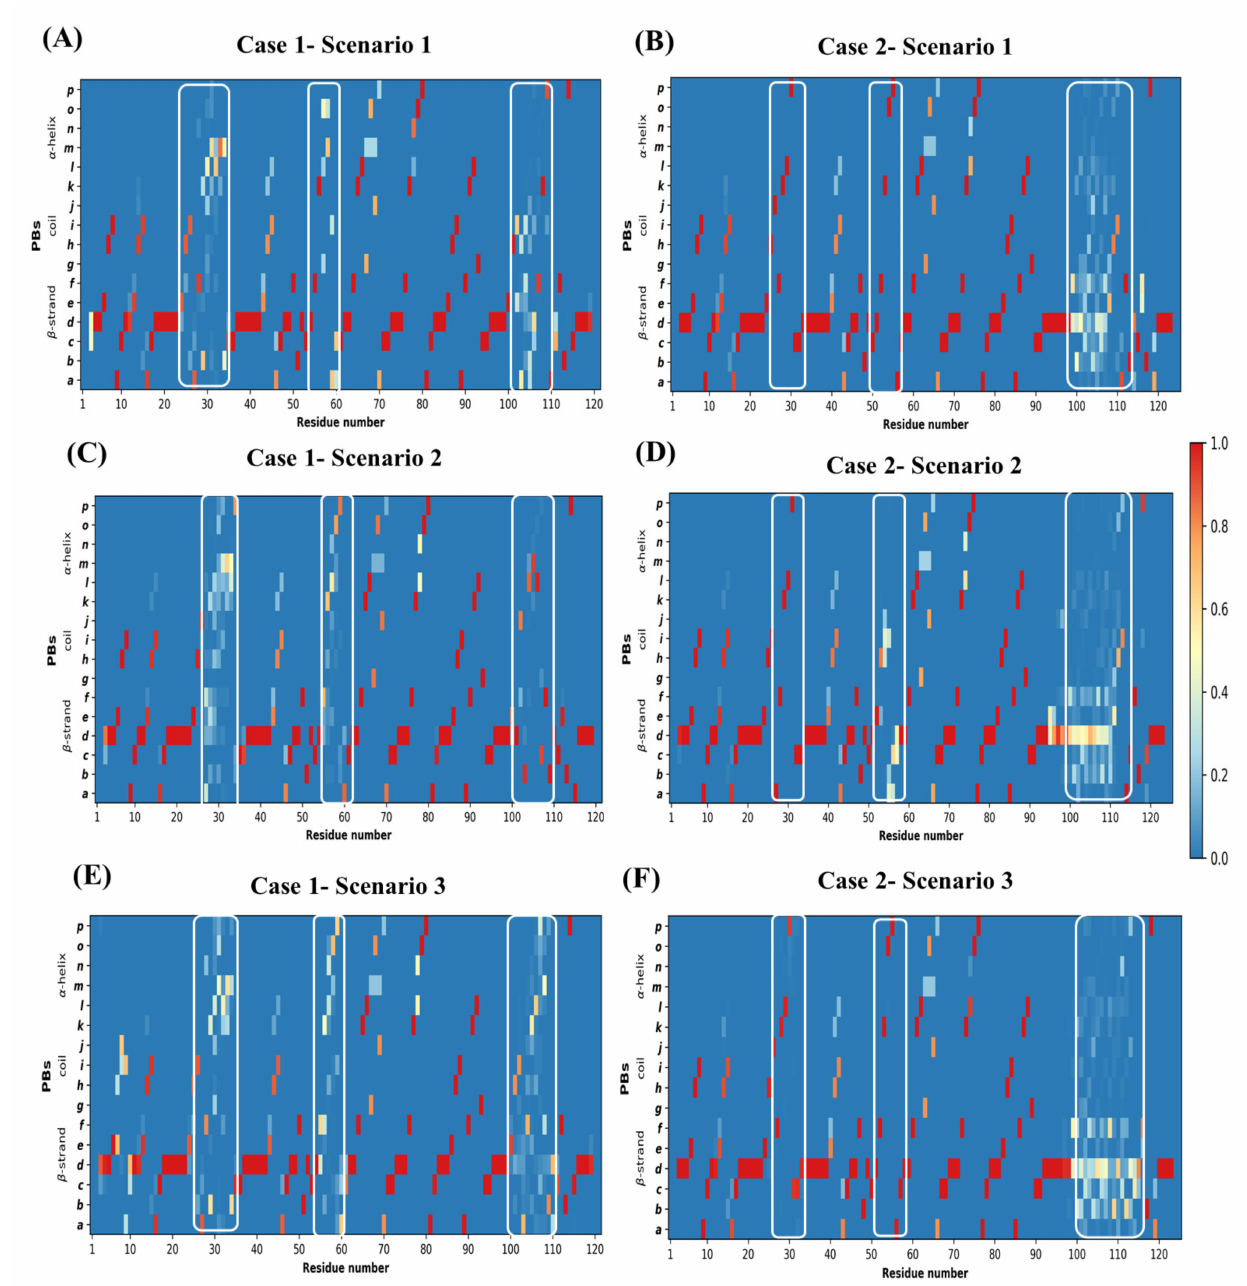
Figure A10. Conformational Sampling in models visualized using protein blocks. Conformational diversity in models represented as PB maps. ( A , C , E ) are PB maps for query sequence PDB ID 4MQS:B modeled in scenario 1, 2, and 3, respectively. ( B , D , F ) are for query sequence PDB ID 5E7B:A modeled in scenario 1, 2, and 3, respectively. The regions enclosed by white rectangles are CDR1, CDR2, and CDR3, denoted from left to right in each